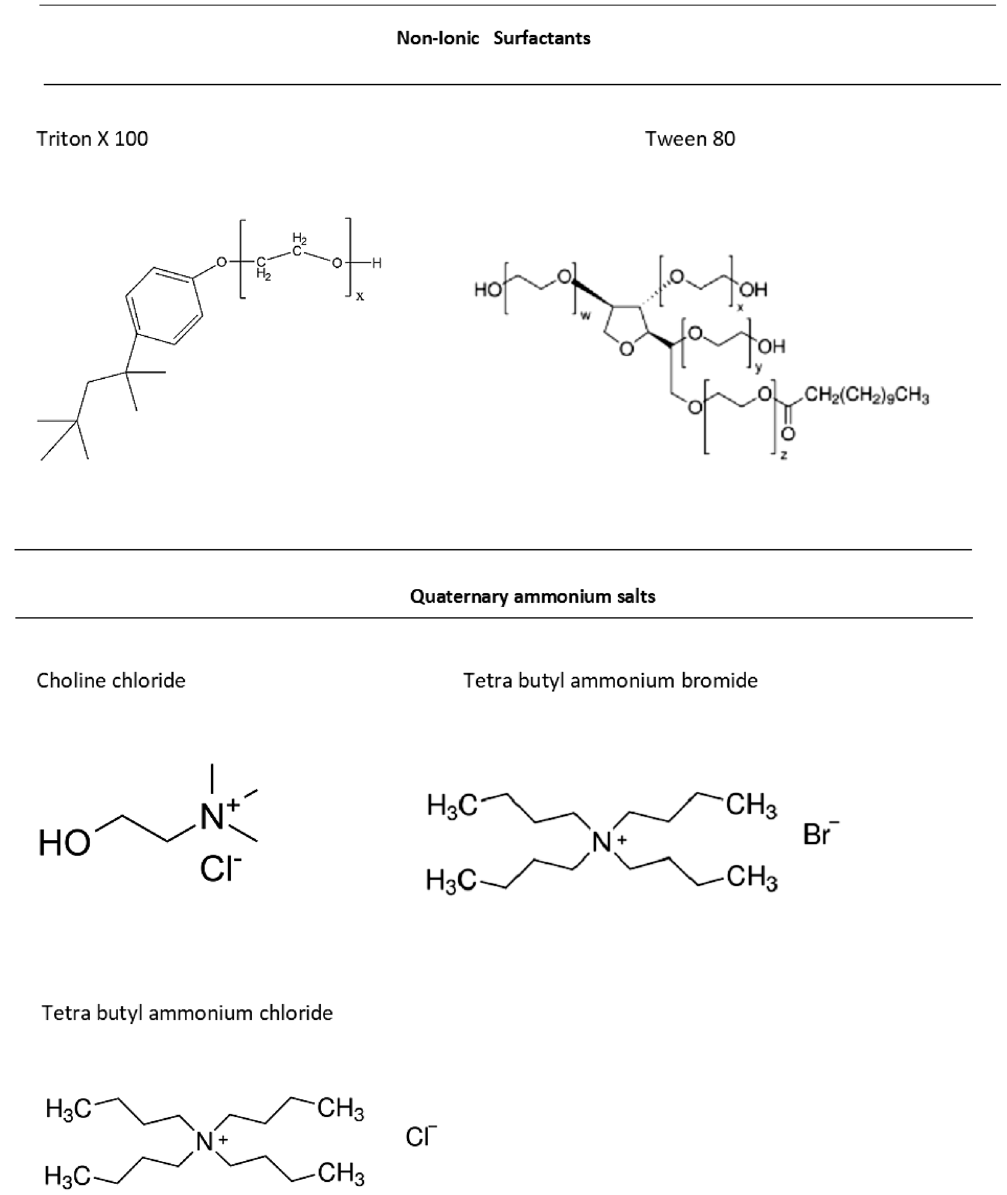
Figure 2. Structures of non-ionic surfactants acting as HBD and quaternary ammonium salts acting as HBA in formation surfactant based deep eutectic solvents